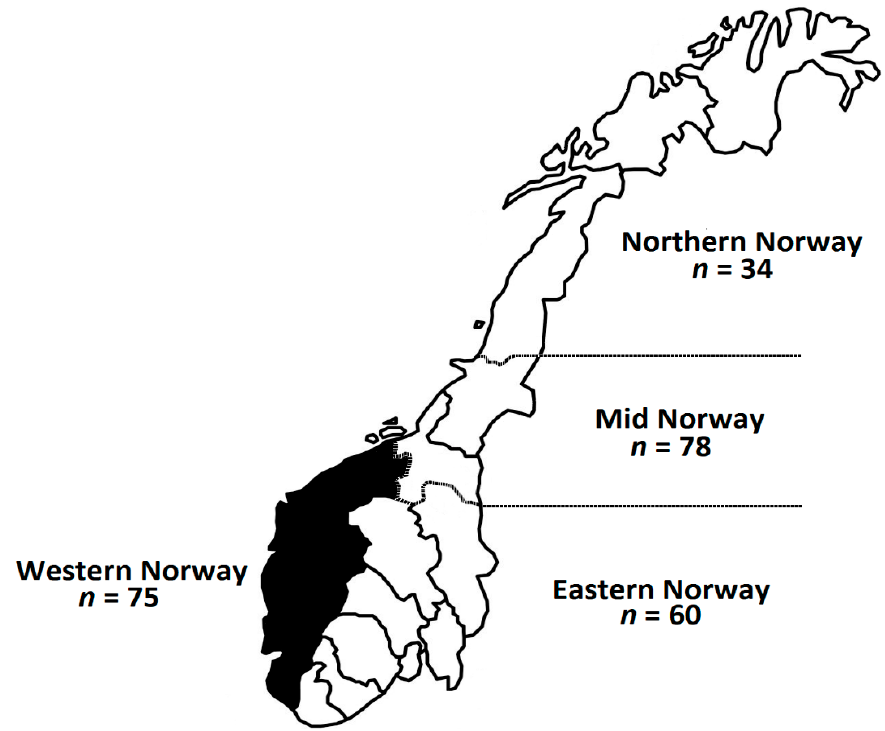
Figure 2. Norwegian map showing the geographical location and distribution of the participants ( n = 247).